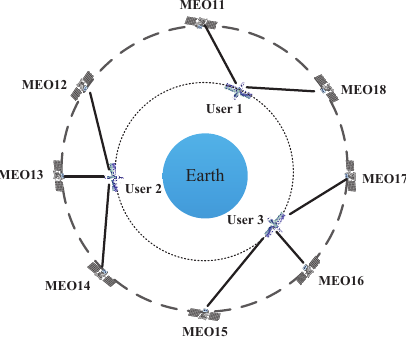
Figure 8. Satellite selection strategy of multiple